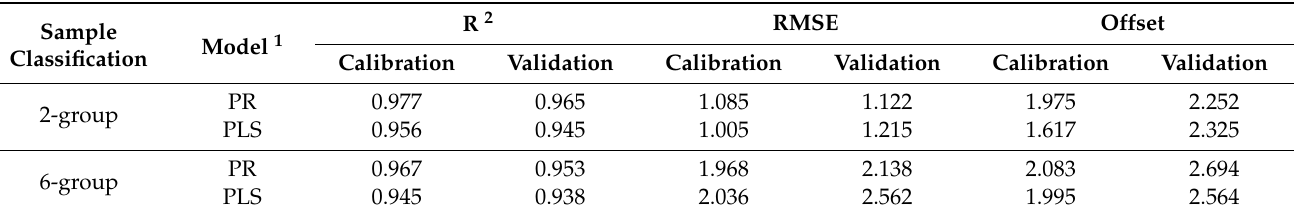
Table 1. Results of principal regression and partial least square models for sample classification prediction based on e-nose output 2 . Sample